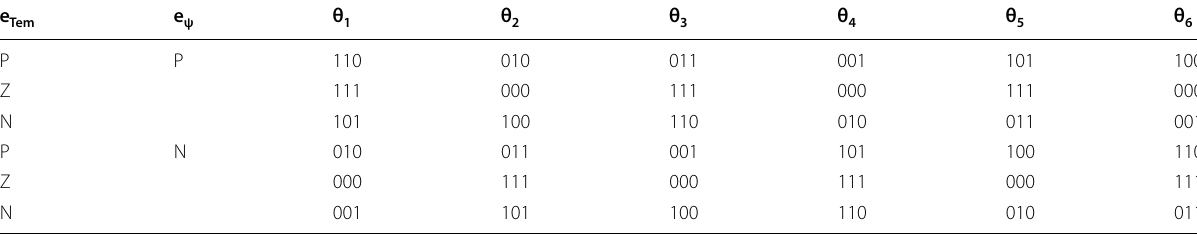
Table 1 Basis of the adopted